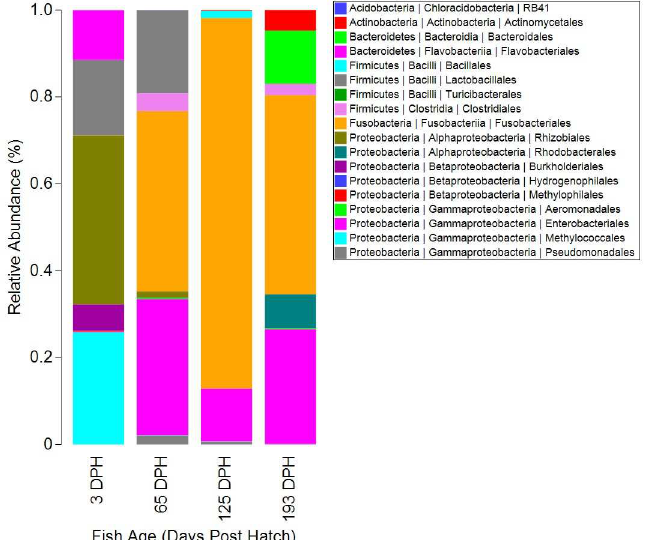
Fig 4. Relative abundance of bacterial orders detected in the intestinal microbiota of channel catfish sampled at 3, 65, 125, and 193 days post hatch (DPH). Bars representthe averages taken from all fish includedin analysisat each time point. Legendindicateshierarchical taxonomy of OTUs at three taxonomic levels (phyla | class | order). Microbiotawere filtered to remove chloroplast OTUs derived from plant material in the diets, and eukaryoticmitochondrial reads, as well as removing OTUs representing less than 0.0001%of the total abundance.